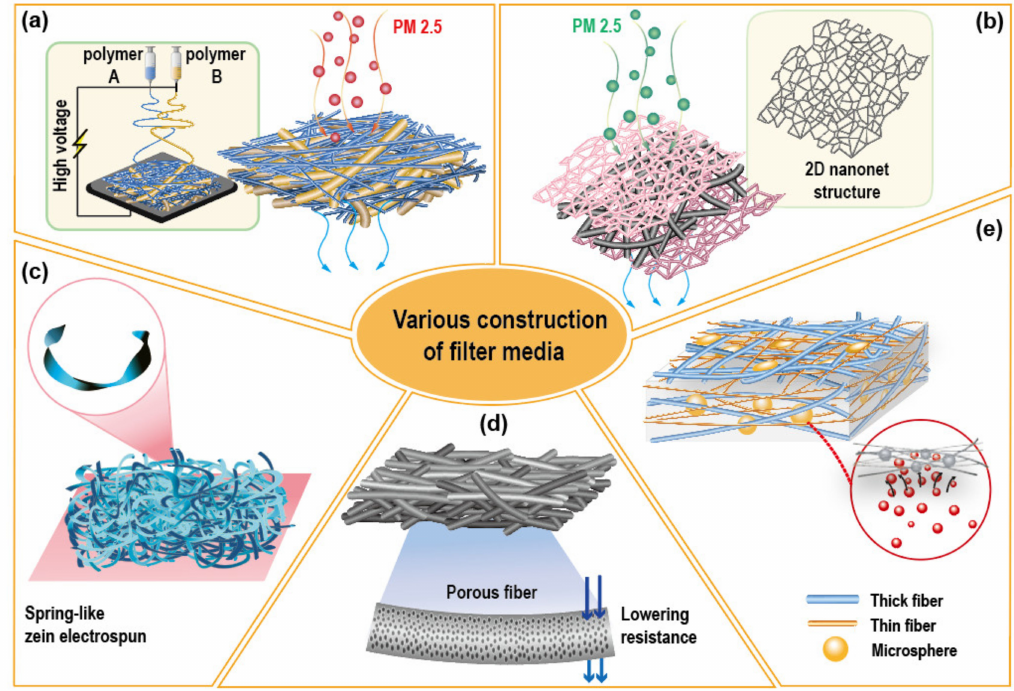
Figure 6. Illustration of various morphology and construction of fibrous assembly applied as filter media. ( a ) Mix of micro and nanofibers by dual electrospinning [63,85,93]; ( b ) Two-dimensional (2D) nanonets with three-dimensional (3D) fibers [84–86]; ( c ) Ribbon-structured fibers for constructing a flu ff y web [65]; ( d ) Porous fibers [73]; ( e ) Hybrid structures with microfiber, nanofiber, and microspheres